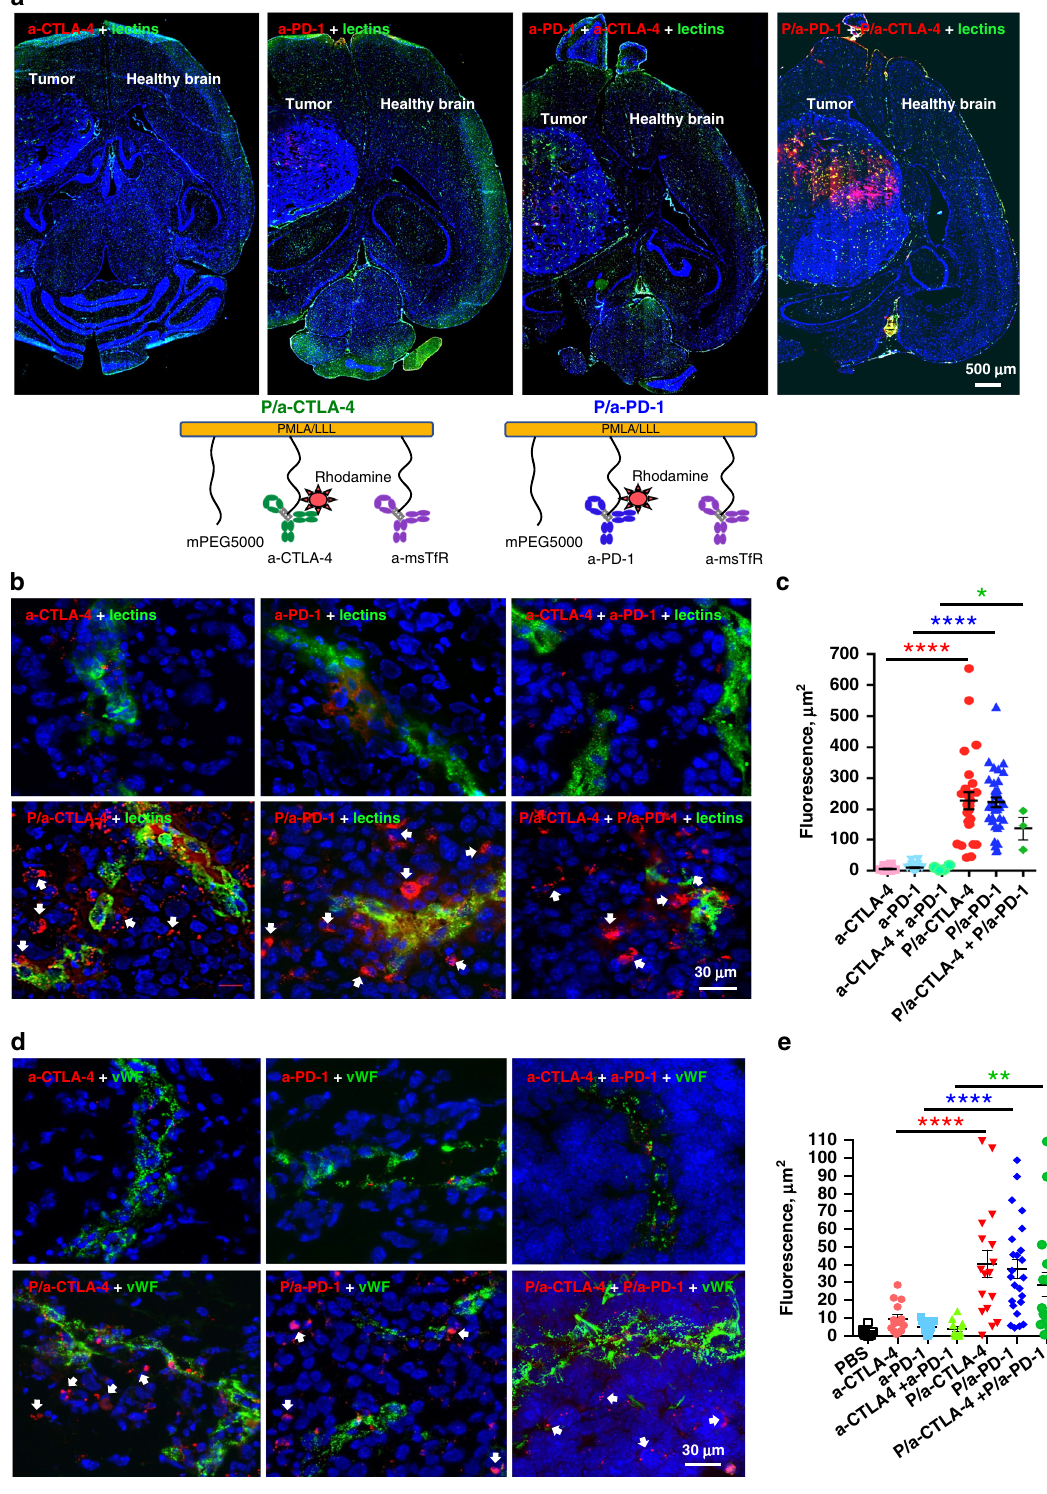
CTLA-4, P/a-PD-1, and their combination (co-injection), com- pared to PBS and free mAbs or their combination (Fig. 3a – c). The Treg fraction (CD4 + FoxP3 + ) signi fi cantly increased in indivi- dual NIC groups only vs. PBS in pairwise comparisons ( F = 14.19, DF = 6, by ANOVA with Sidak ’ s posttest, p < 0.0001). NIC combination did not signi fi cantly increase Tregs vs. either PBS or